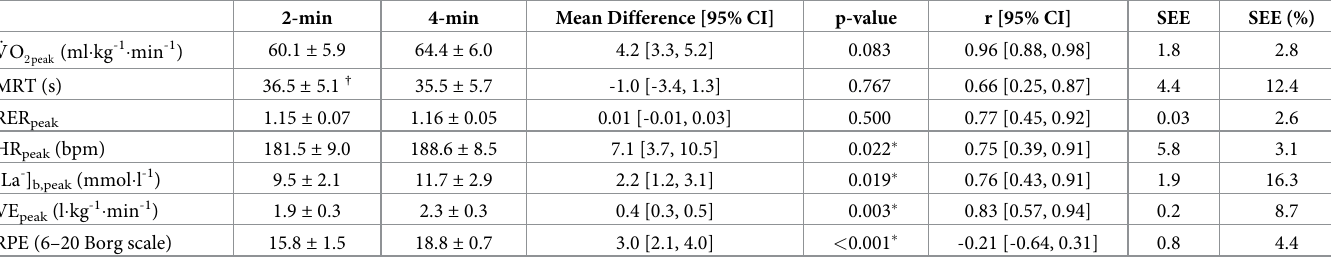
Table 1. Physiological variables and perceived exertion observed in the 2-and 4-min CWR tests ( n =